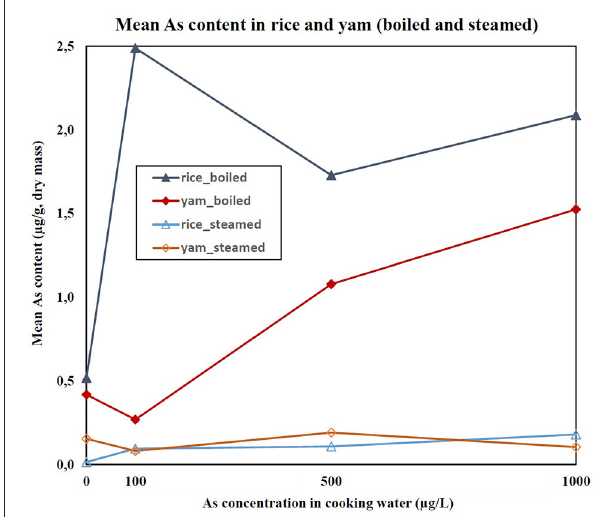
FIGURE 4 | Mean As content in boiled and steamed rice and yam ( µ g/g, DM) as a function of As concentration in cooking water ( µ g/L). Errors bars are given in Supplementary Table 6 .